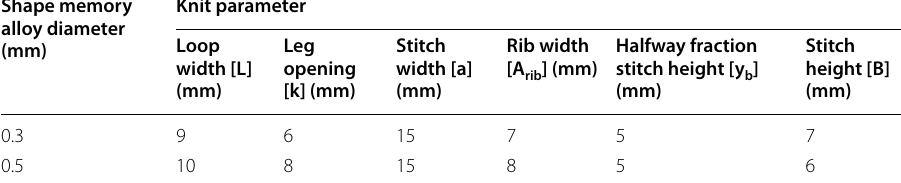
Table 1 Knit parameters of shape memory textile actuator 0.3 mm, 0.5